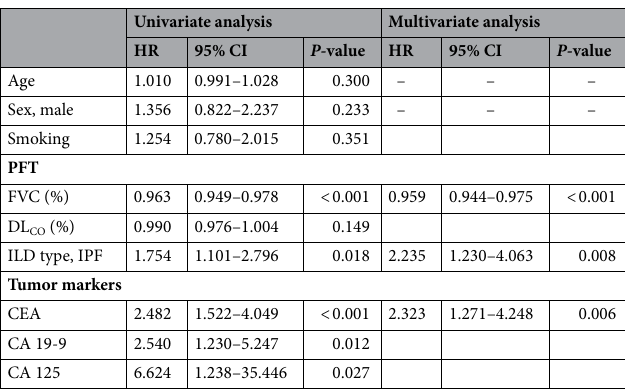
Table 3. Prognostic factor for mortality in 294 patients with ILDs. HR hazard ratio, CI confidence interval, IPF idiopathic pulmonary fibrosis, ILD interstitial lung disease, PFT pulmonary function test, FVC forced vital capacity, DL CO diffusing capacity of the lung for carbon monoxide, ILD interstitial lung disease, CEA carcinoembryonic antigen, CA carbohydrate antigen.